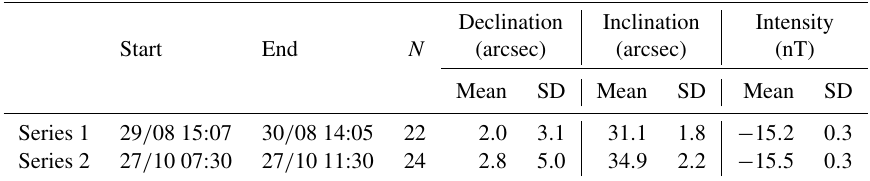
Figure 2. Mean differences (in red) and SDs (in blue) of the three components of CL1 and CL2 variometers and associated scalar instruments for year 2014. The red crosses can be seen as the cumulated baseline values of the CL1 and CL2 instruments. Table 2. Statistics obtained from series of absolute magnetic data during 2016, assuming constant baselines for all data of a series. The number of valid data for each time series is N